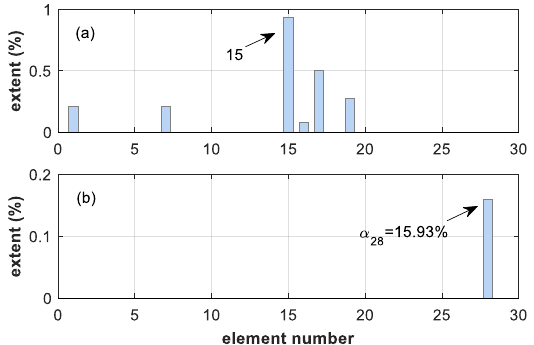
Figure 17. Damage identification results of damage case F at a 3% level of noise, with an iterative Tikhonov solution: ( a ) CMSE method; ( b ) RCMSE method.